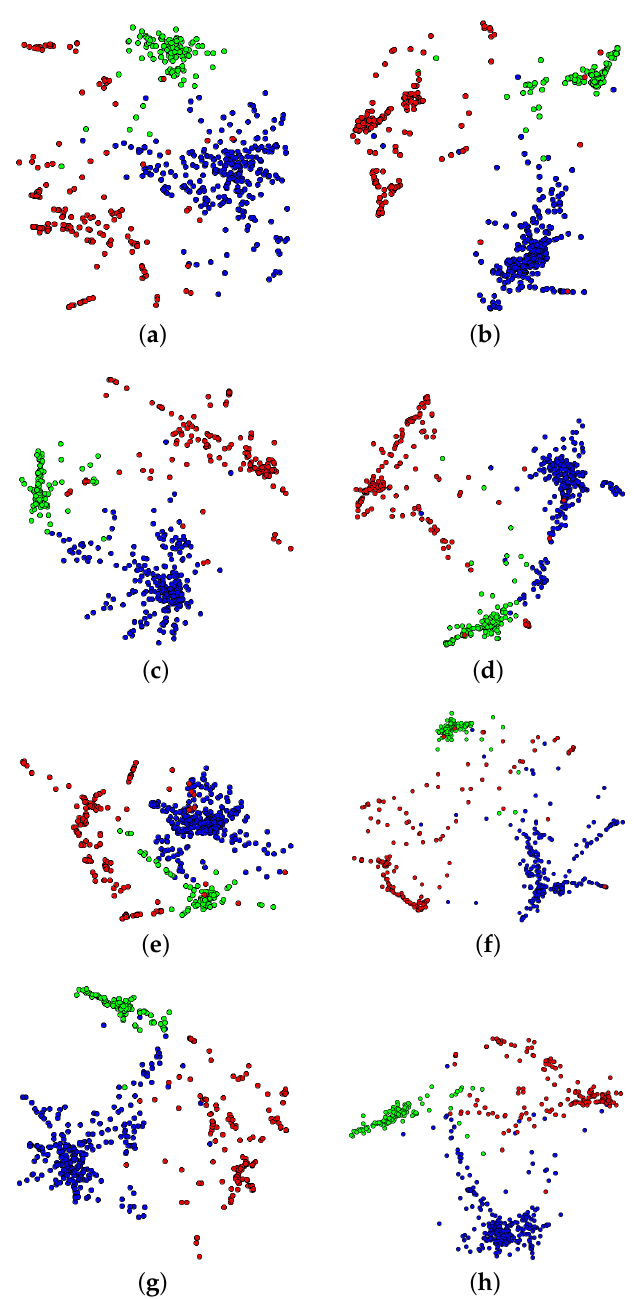
Figure 4. Projection models computed from the Case-Based Reasoning (CBR), Inductive Logic Programming (ILP), Information Retrieval (IR) (CBR-ILP-IR) dataset. The Least Squares Projection (LSP) [13] technique was employed to generate these graphical representations. ( a ) no stem-TF-IDF-LC1; ( b ) no stem-TF-IDF-LC475; ( c ) no stem-TF-LC1; ( d ) no stem-TF-LC475; ( e ) Porter stem-TF-IDF-LC1; ( f ) Porter stem-TF-IDF-LC475; ( g ) Porter stem-TF-LC1; ( h ) Porter